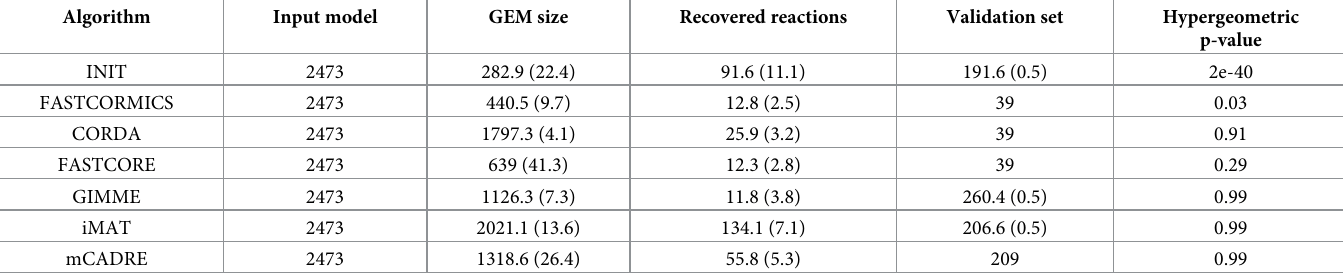
Table 2. Cross-validation test results for the context-specific algorithms under